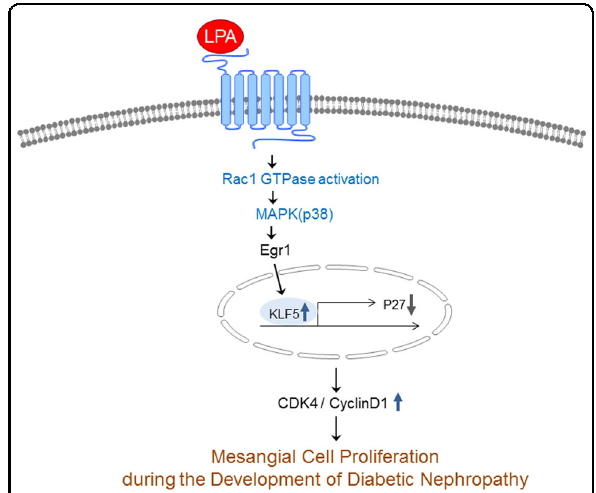
Fig. 7 Schematic of the mechanism by which LPA induced mesangial cell proliferation in diabetic nephropathy models through Rac1/ MAPK/KLF5